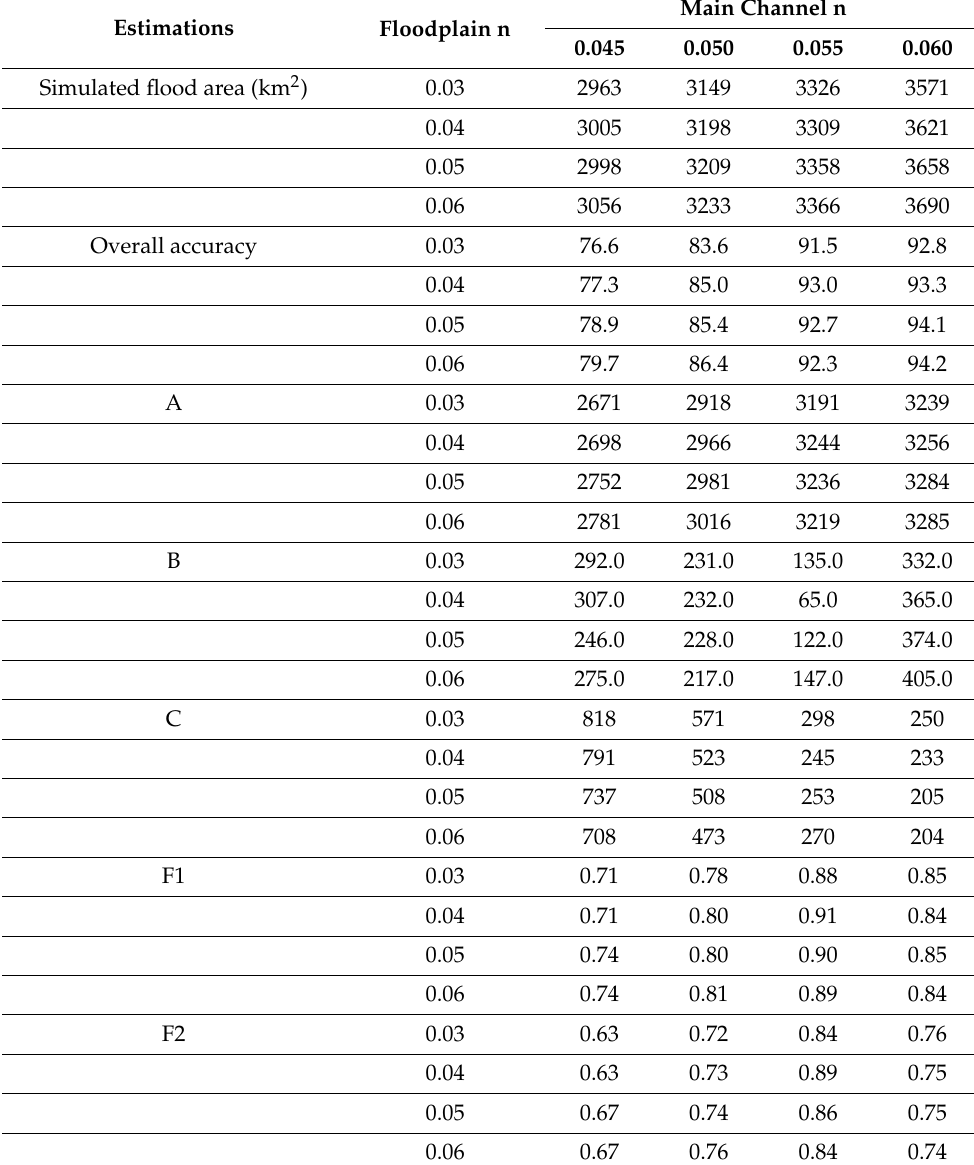
Table 4. Validation assessment of the model using overall accuracy, F1, and F2 for the 2014